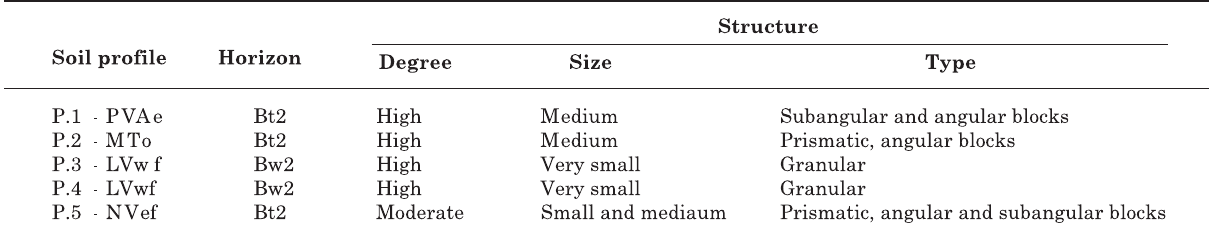
Table 2. Degree, size and type of structure determined in horizon B of soil